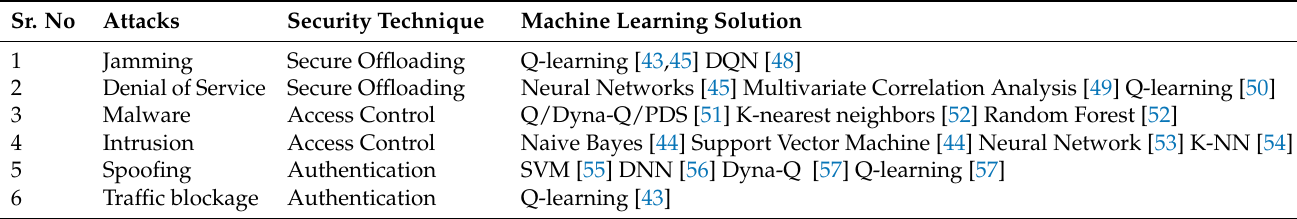
Table 2. Typical cybersecurity and data privacy threats to smart